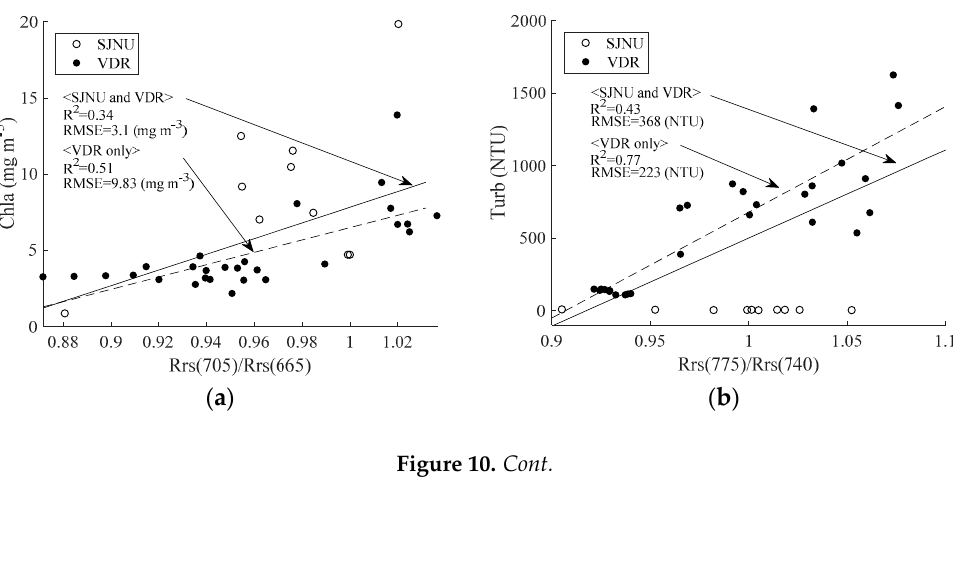
Table 6. Optimal turbidity algorithm using the T1, T2 and T3